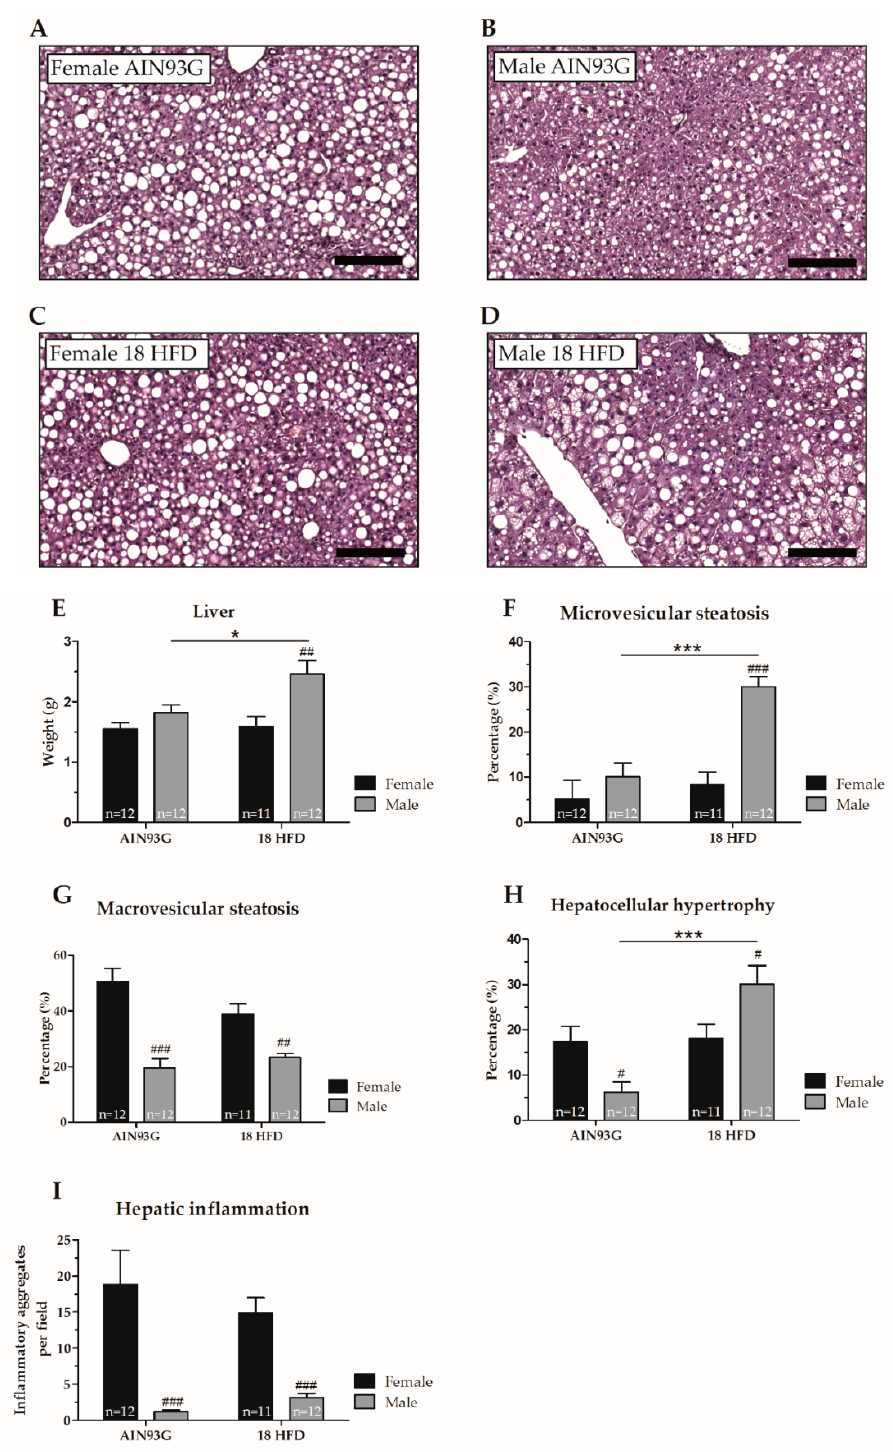
Figure 6. Analyses of histological hallmarks of non-alcoholic fatty liver disease after 18 weeks of AIN93G diet or HFD feeding in young Ldlr-/-.Leiden male and female mice. Representative images of haematoxylin and eosin-stained liver tissue per experimental group ( A – D ). Scale bar is 100 µm. ( E ) Liver weight, ( F ) microvesicular steatosis, ( G ) macrovesicular steatosis, ( H ) hepatocellular hypertrophy, ( I ) hepatic inflammation. * p ≤ 0.050 and *** p ≤ 0.001 significant dietary effect. # p ≤ 0.050, ## p ≤ 0.010 and ### p ≤ 0.001 significant effect in sex.